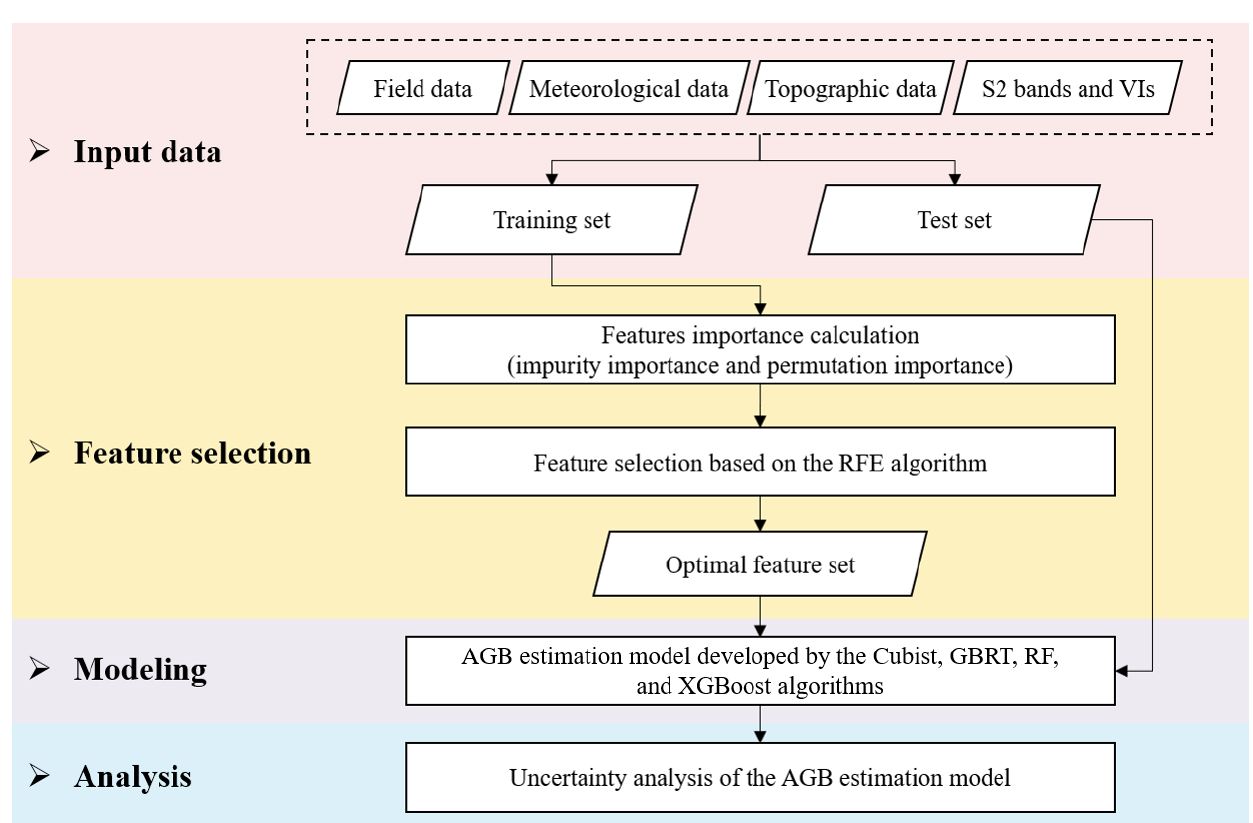
Figure 2. Flowchart of the grassland AGB estimation and